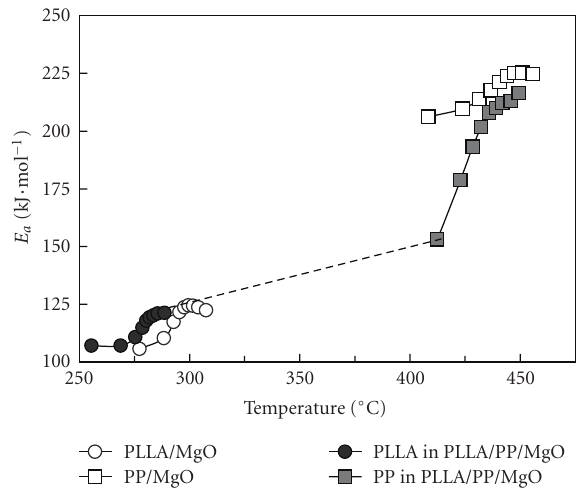
Figure 7: Activation energy, E a , plots against temperature for thermal degradation of PLLA/MgO, PP/MgO, and PLLA/PP/MgO blend. ϕ = 5 ◦ Cmin − 1 .